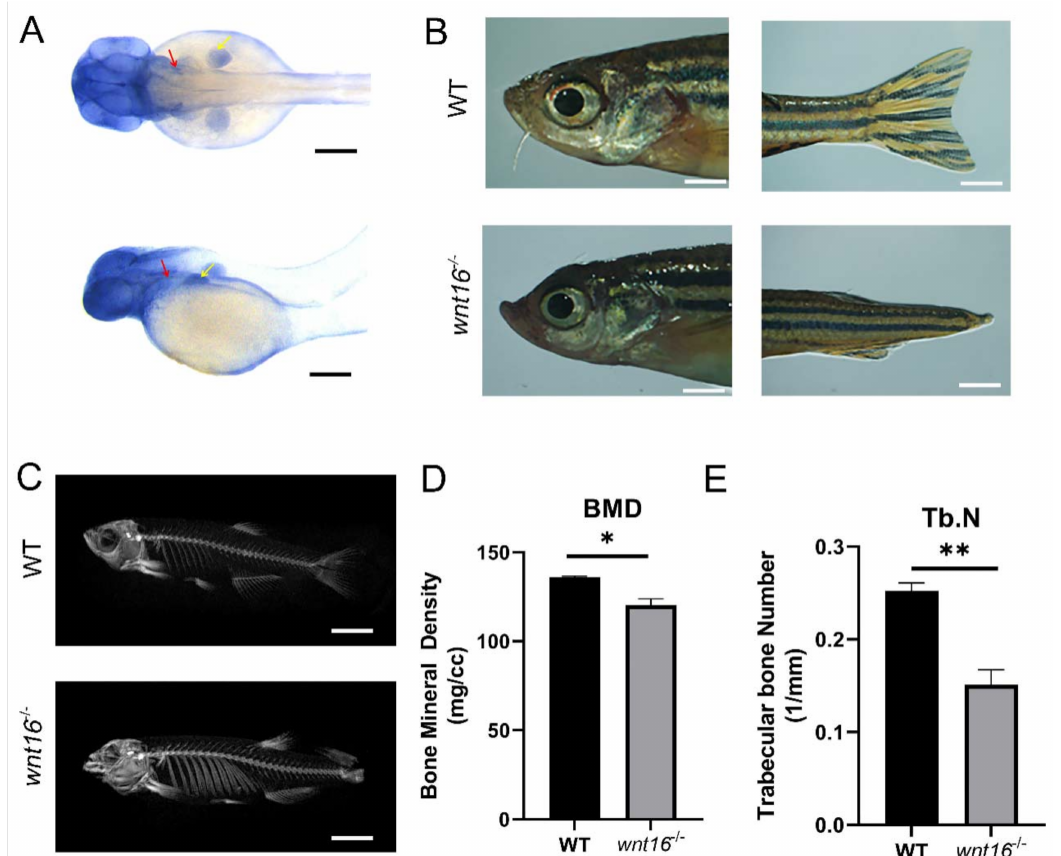
Figure 3. Images of zebrafish generated by WISH, light microscopy, and micro-CT and skeletal statistical analysis. ( A ) Images of whole-mount in situ hybridisation with wnt16 mRNA probes in WT larvae at 48 hpf. Colour intensity is proportional to the expression level of wnt16 gene. Arrowheads indicate relevant domains of expression. Yellow, pectoral fin bud (pfb); red, operculum (op). ( B ) Representatives of adult WT and wnt16 − / − mutant zebrafish are shown. Apparent abnormality was observed in the head and tail of wnt16 − / − mutant zebrafish. ( C ) Micro-CT scanning of WT and wnt16 − / − mutant zebrafish skeleton. Obvious abnormality was observed in the mandible and spine of wnt16 − / − mutant zebrafish. ( D , E ) Statistical analysis of BMD ( D ) and Tb.N ( E ) in WT and wnt16 − / − zebrafish. Note that BMD and Tb.N value decreased in the wnt16 − / − group. The results are represented as means ± SEM, * p < 0.05, ** p < 0.01. Scale bar: 150 µ m ( A ); 2 mm ( B ); 6 mm ( C